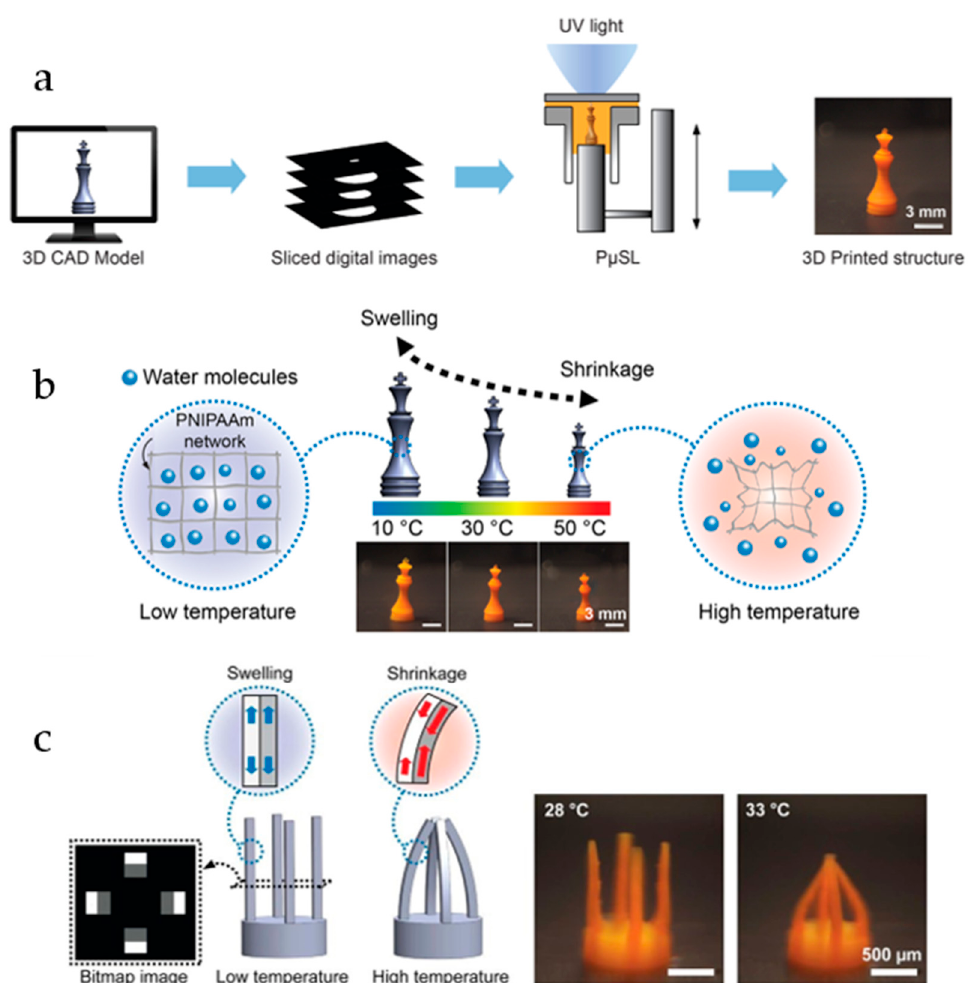
Figure 3. 3D printing of PNIPAAm thermo-responsive hydrogel: ( a ) schematic illustrating of the printing process that goes from the drawing of the 3D model with computer-aided-design (CAD) software, that is then digitally sliced into a series of cross-sectional images. The 3D structure is obtained with P μ SL by curing the liquid resin with a series of masks (derived from each slice) optically patterned with ultra-violet light; ( b ) schematic drawing of the temperature response of the 3D printed hydrogel with a phase change when the temperature decreases or increases, observed by swelling and shrinkage, respectively. In the middle (photographs), one can see this effect on the printed 3D structure (at T of 10, 20 and 50 °C); ( c ) in this sequence of sketches and pictures one can see, from left to right, a slice of the gripper with two arms and two different levels of gray to be able to produce a 4 arm 3D structure. The arms of this hydrogel bend when the temperature is higher than the temperature transition, depicted in the central region, and photos of the bending responsive observed when the 3D gel is placed at 33 °C (Figure adapted under the terms of the CC BY 4.0 License) [26].